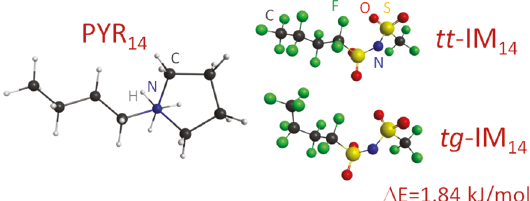
cation and of the low energy 14 14